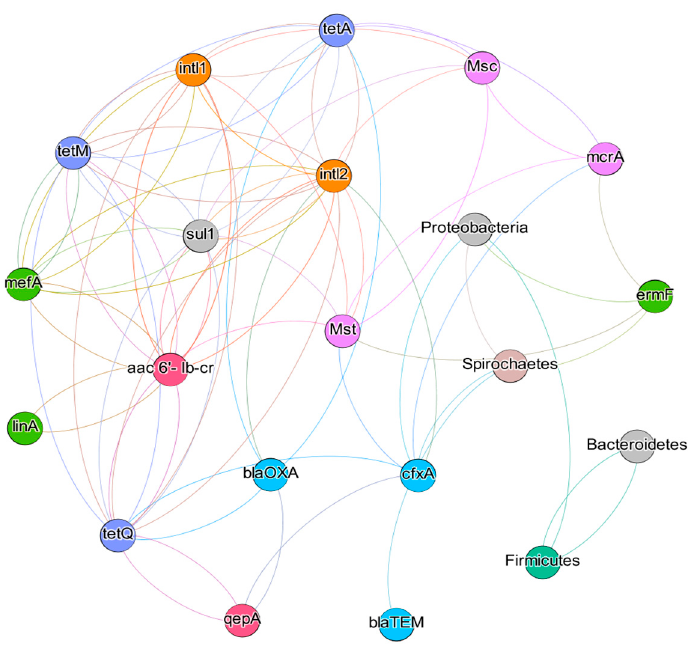
Figure 3. The network analysis showing the co-occurrence patterns between the detected ARGs and microbial taxa (type level). The nodes were coloured according to ARGs types and bacterial taxa. The connection between ARGs and bacterial taxa represents a strong (Spearman’s correlation coefficient R > 0.7) and significant ( p -value < 0.01) correlation. Node size is proportional to the number of connections; edge width is proportional to Spearman’s p